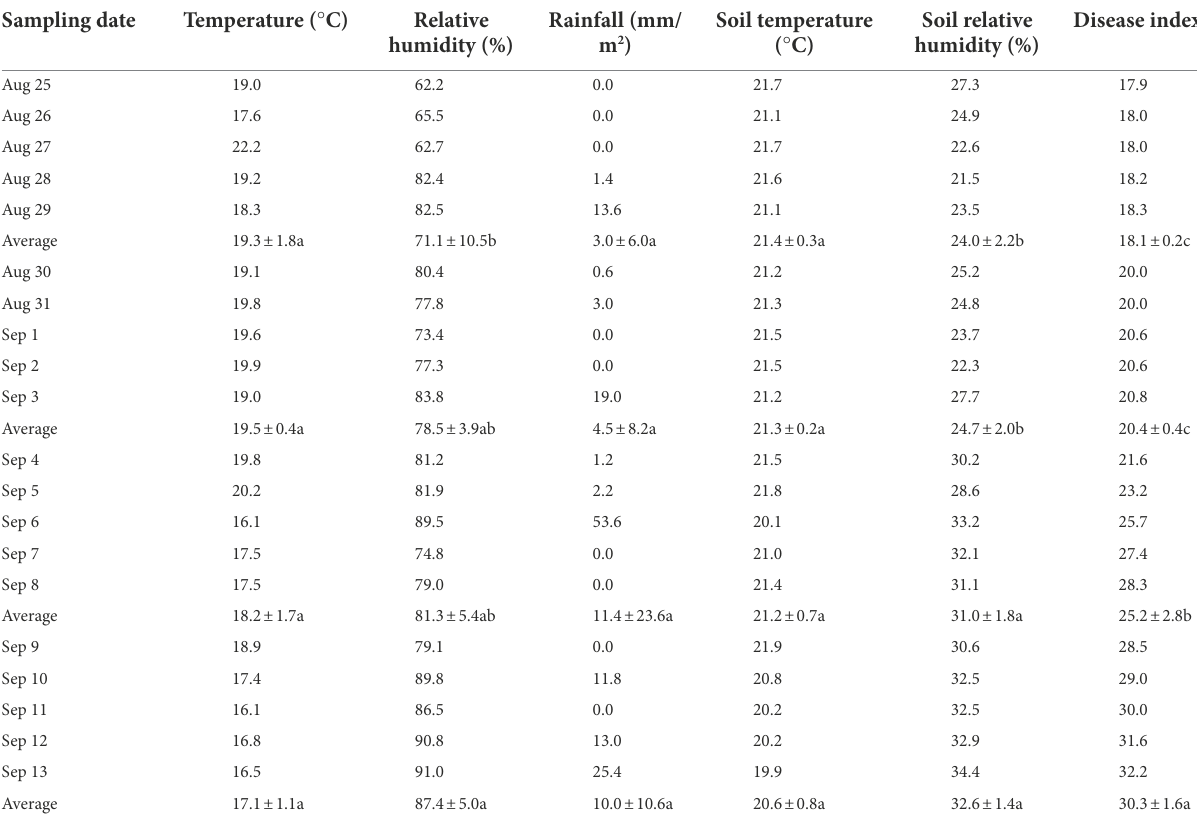
TABLE 1 Environmental factors and symptomatic tobacco plant disease indices in tobacco